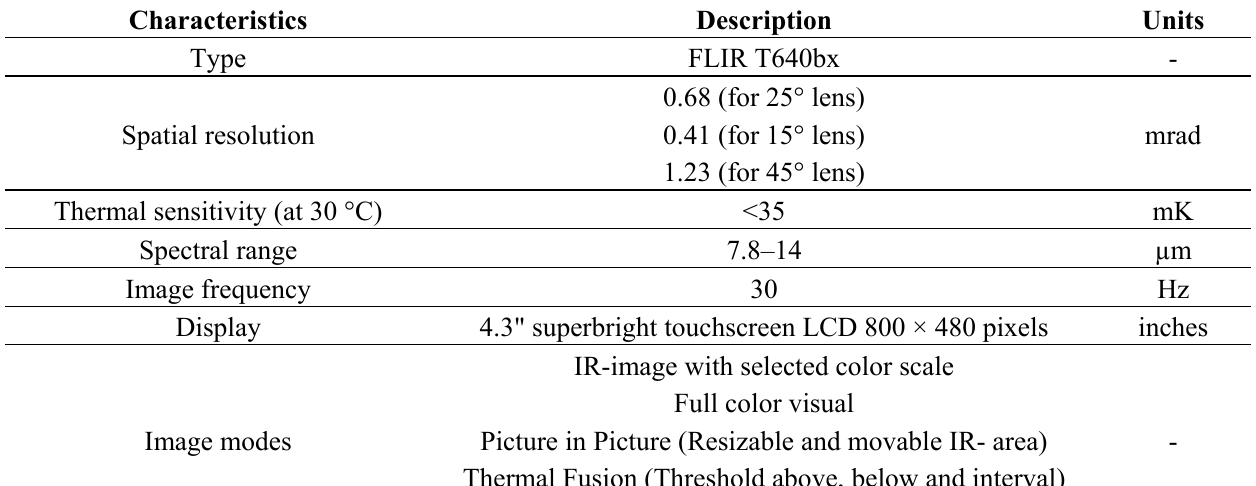
Table 1. Technical specifications of the infrared camera used for the infrared campaign.